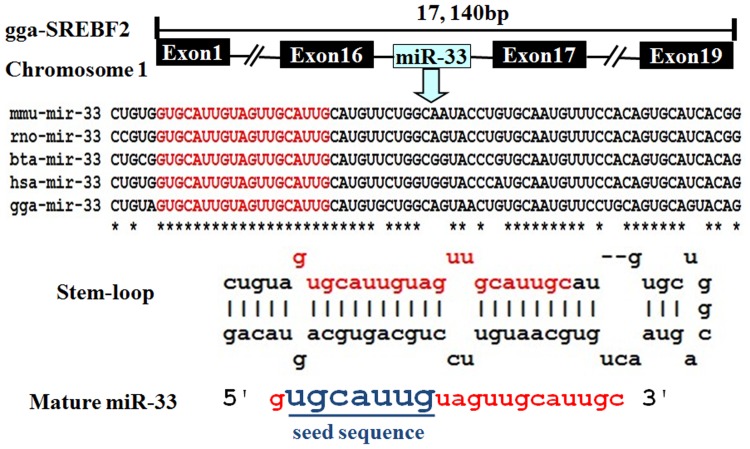
Prediction of transcription of chicken miR-33 from the chicken SREBF2 gene.A miR-33 stem-loop is predicted from intron 16 of SREBF2, and the sequence of this part of the SREBF2 gene is highly conserved across mammalian species (mmu: mouse; rno: rat; bta: cow; hsa: human) and chicken (gga: chicken).